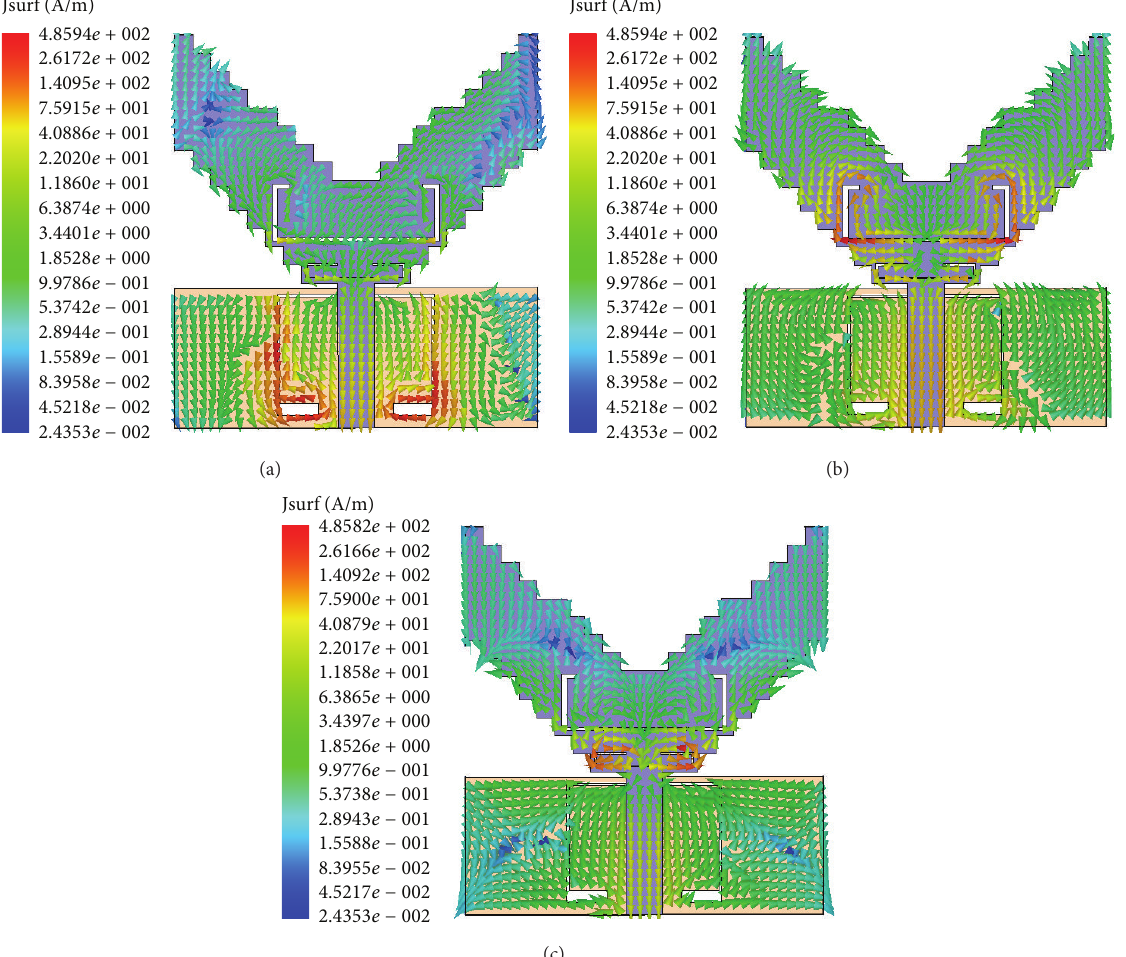
Figure 9: The current distribution on the proposed antenna at (a) 2.2 GHz, (b) 3.54 GHz, (c) 5.68 GHz.